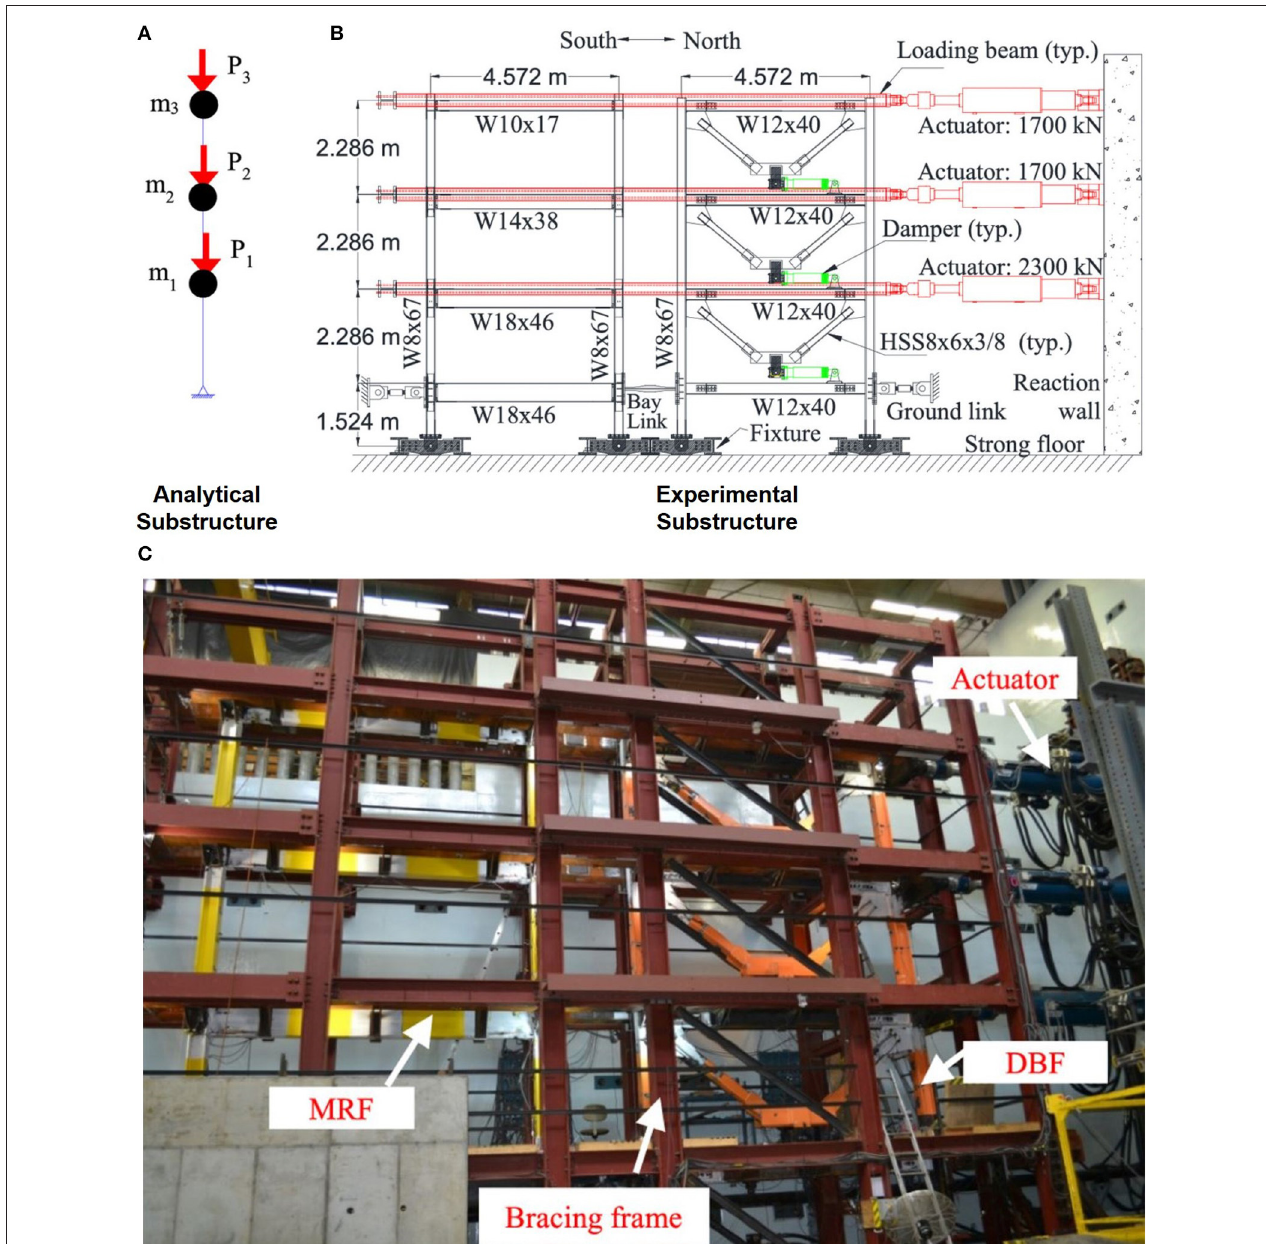
FIGURE 8 | RTHS substructures of a three-story building equipped with non-linear viscous dampers: (A) analytical substructure, (B) experimental substructure, and (C) experimental test setup (reprinted from Dong et al., 2018b with